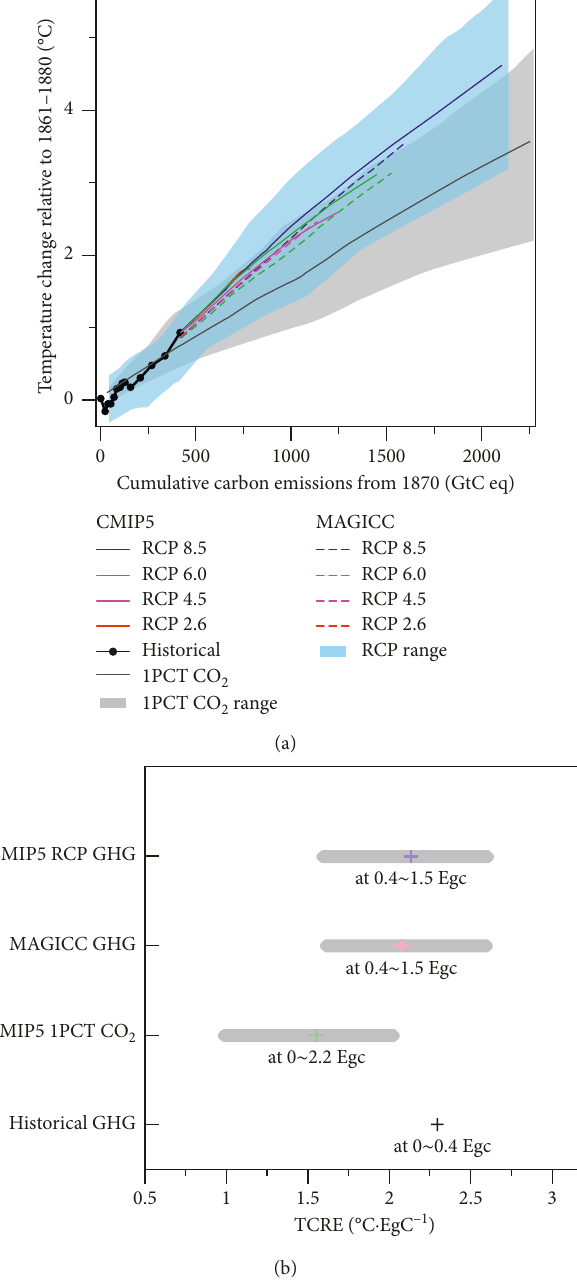
Figure 3: Globaltemperaturechangeasafunctionofcumulativecarbon emissionsfromvariouslinesofevidence.(a)SimulatedGHG-attributable warming as a function of cumulative emissions based on representative concentration pathway (RCP) and 1% · yr − 1 CO 2 increase (1PCT) sim- ulations from the fifth phase of the Coupled Model Intercomparison Project (CMIP5) and Model for the Assessment of Greenhouse Gas Induced Climate Change (MAGICC) experiments. The MAGICC was used in order to compare the results of CMIP5 models used in IPCC Working Group 1 to the MAGICC model results in Working Group 3. (b) The ratio of GHG-attributable warming to cumulative carbon emissions (TCRE). The ranges of numbers in panel (b) indicate the amounts of cumulative emissions from the horizontal axis of (a) for each simulation. These values indicate different ratios of TCRE at different amounts of cumulative emissions from various RCP